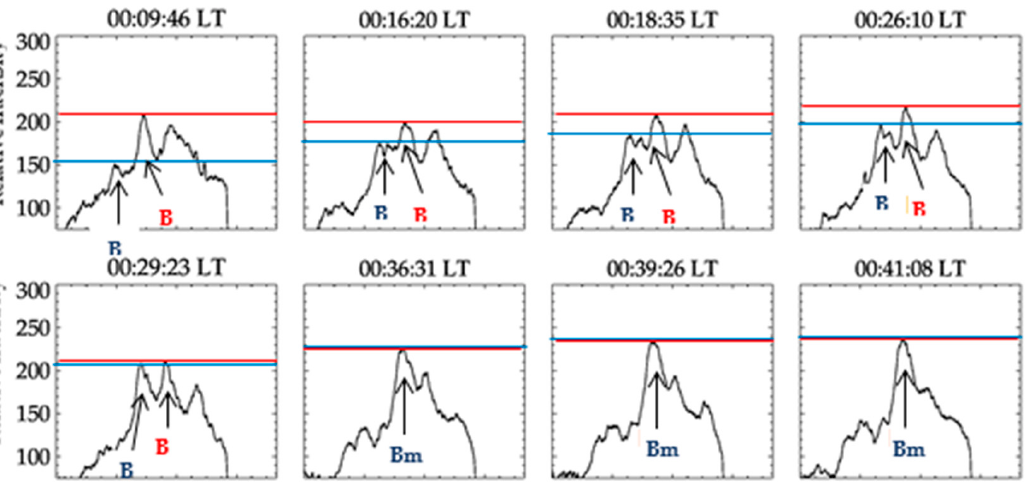
Figure 7. Relative intensity profile of plasma blob merging. The red line tracks the peak relative intensity of B1 while the blue line tracks the peak relative intensity of B2.